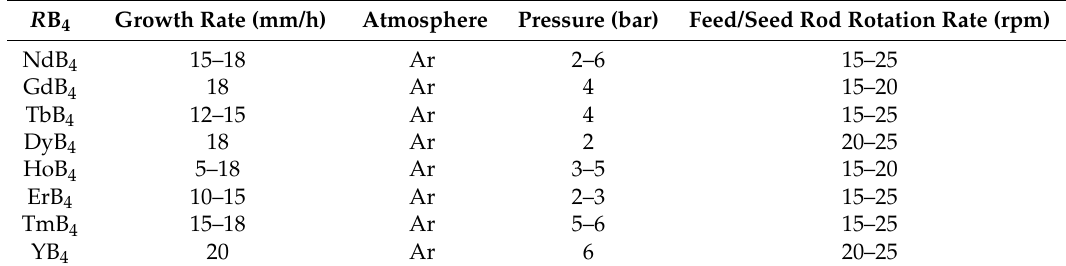
Table 1. Summary of the conditions used for the growth of R B 4 (with R = Nd, Gd → Tm, and Y) crystal